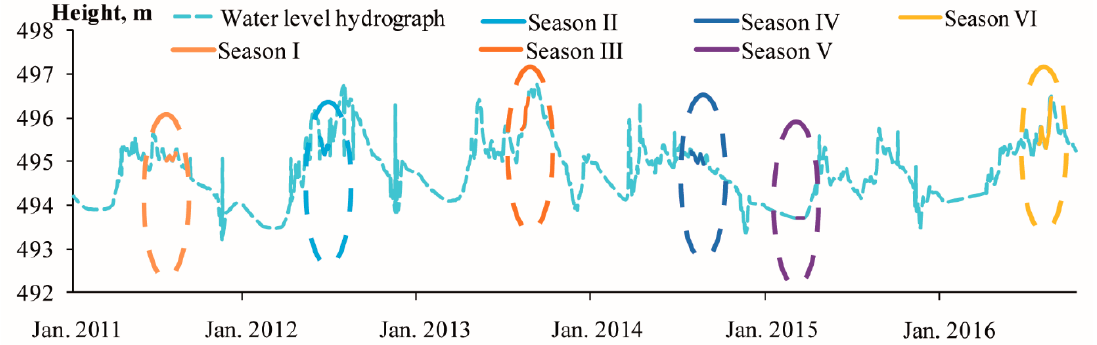
Figure 2. Water level (at gauging station Ulan-Ude) and hydrological seasonality of the Selenga River during field campaigns of 2011–2016.